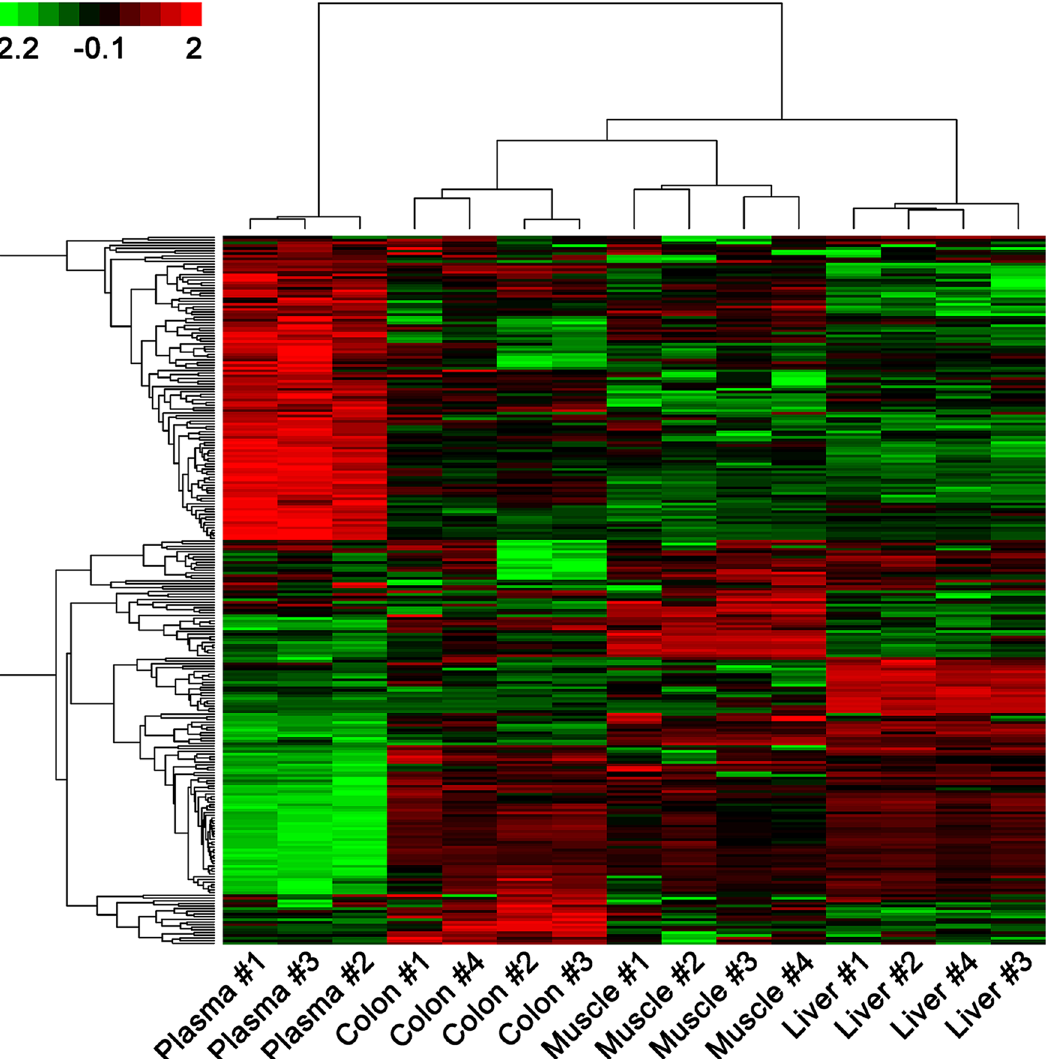
Fig 2. Unsupervised hierarchical clustering of horse miRNA expression profiles. Values in the color key represent z-transformed expression values, such that highest expression values of each row correspond to bright red, and the lowest to bright green. Plasma samples constitute a distinct cluster, separated from the other three tissue